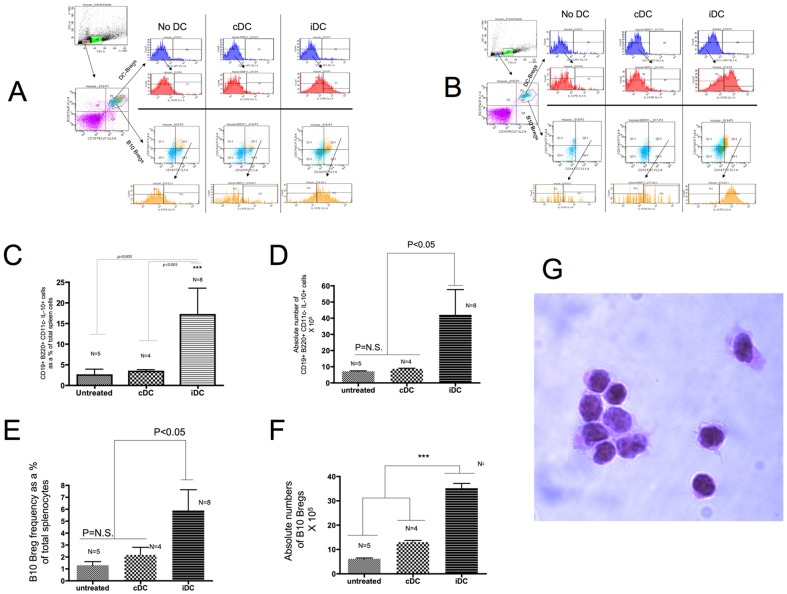
iDC administration into NOD mice promotes an increase in the frequency of CD19+ B220+ CD11c− IL-10+ B-cells as well as B10 Bregs in vivo.2×106 cDC or iDC were injected into NOD female mice (8–10 weeks) s.c. into the abdominal flank overlying the gastrointestinal organs. Three days later, the spleens were collected and the frequency of the CD19+ B220+ CD11c− IL-10+ B-cells as well as B10 Bregs was measured by flow cytometry. Absolute numbers were calculated based on hematocrit measurements of total viable single cells recovered from the tissue. a. Shown is the flow cytometric approach used to identify and measure the frequency of the CD19+ B220+ CD11c− IL-10+ cells (DC-Bregs; top two histograms) and B10 Bregs (bottom two histograms). The results shown are representative of analyses conducted in freshly-collected splenocytes of at least four different NOD recipients of each type of DC population (and PBS vehicle control). b. The data are representative of analyses conducted in freshly-collected pancreatic lymph node single cells acquired from the same mice (n = 4 per treatment type) referred to above in (a). c. The graph summarises the frequency of CD19+ B220+ CD11c− IL-10+ B-cells (DC-Bregs) measured by flow cytometry as a % of total splenocytes. The number of mice from which tissue was collected per treatment type is shown at the top of the bars which represent the median value. The error bars reflect the SD. The differences between iDC and cDC/control untreated were statistically-significant (p<0.005, Kruskal-Wallis test of variance). d. The graph summarises the absolute number of DC-Bregs measured by flow cytometry in the freshly-collected spleens of the untreated, cDC and iDC-injected NOD mice (same mice as in [c] above). The bars represent the medians and the error bars the SD. The differences among the medians was statistically-significant as shown in the graph (Kruskal-Wallis test of variance). e. The graph summarises the frequency of B10 Bregs (CD19+ CD1d+ CD5+ Il-10+ cells) measured by flow cytometry as a % of total splenocytes. The number of mice from which tissue was collected per treatment type is shown at the top of the bars which represent the median value. The error bars reflect the SD. The differences between iDC and cDC/control untreated were statistically-significant (p<0.05, Kruskal-Wallis test of variance). f. The graph summarises the absolute number of B10 Bregs measured by flow cytometry in the freshly-collected spleens of the untreated, cDC and iDC-injected NOD mice (same mice as in [e] above). The bars represent the medians and the error bars the SD. The differences among the medians was statistically-significant (p<0.005, Kruskal-Wallis test of variance). g. Hematoxylin/Eosin-stained cytospin of flow-sorted B10 Bregs. Cells were sorted from freshly-isolated splenocytes of a 10 week-old female non-diabetic NOD mouse. Magnification ×63. The morphology is identical among cytospins from another 5 age-matched female NOD mice.